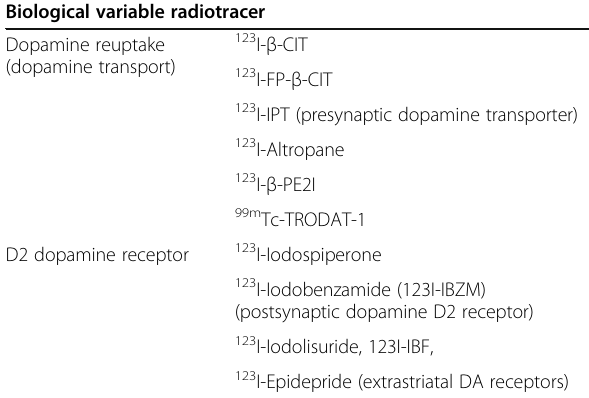
Table 2 Some radiotracers used for Parkinson ’ s disease SPECT Biological variable radiotracer Dopamine reuptake (dopamine